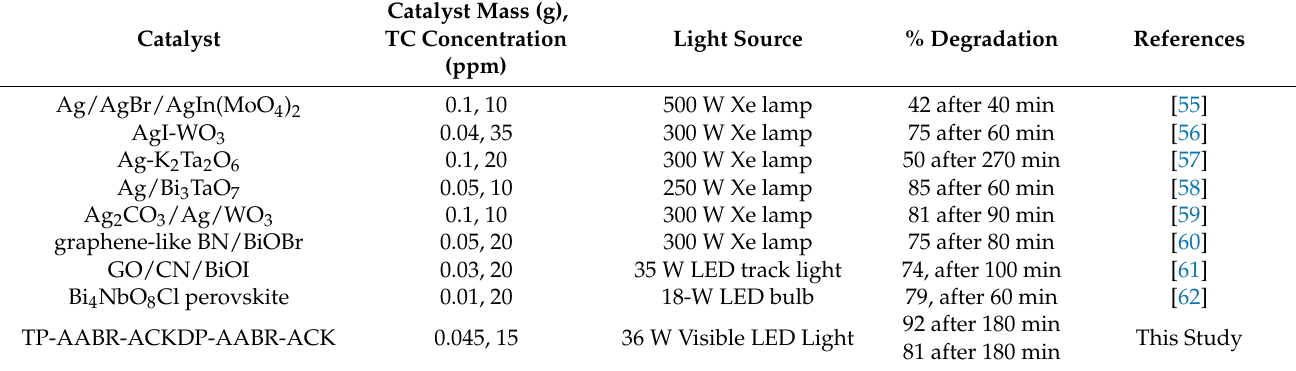
Table 1. Comparison of degradation efficiency of different heterostructures with AABR-ACK composites on tetracycline removal.